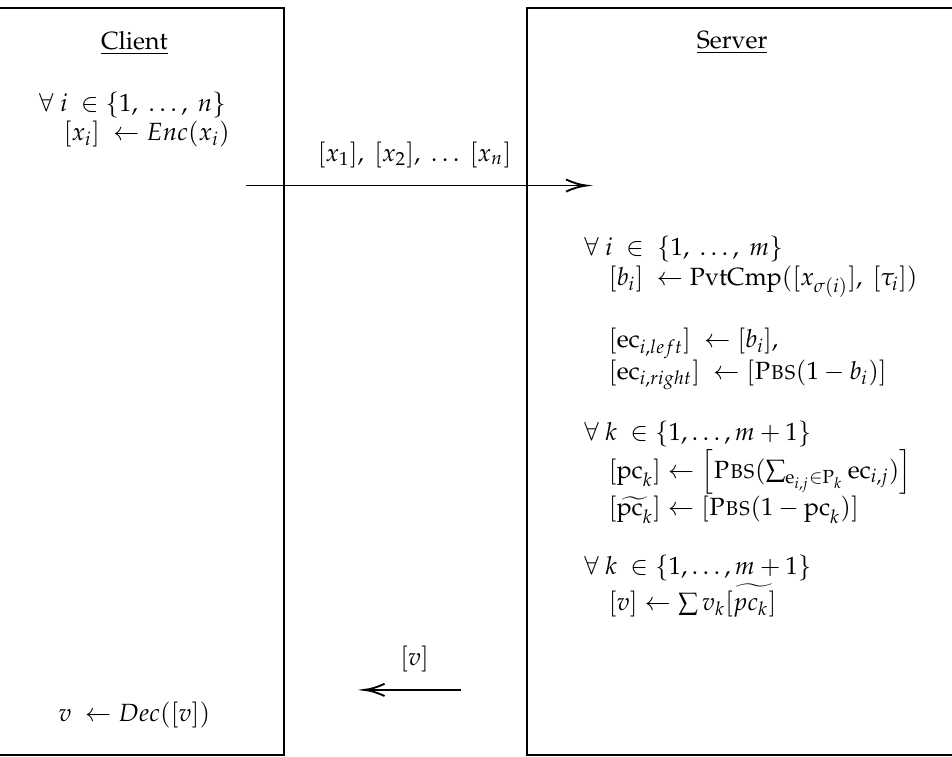
Figure 10. Private decision tree evaluation using our private comparison function.